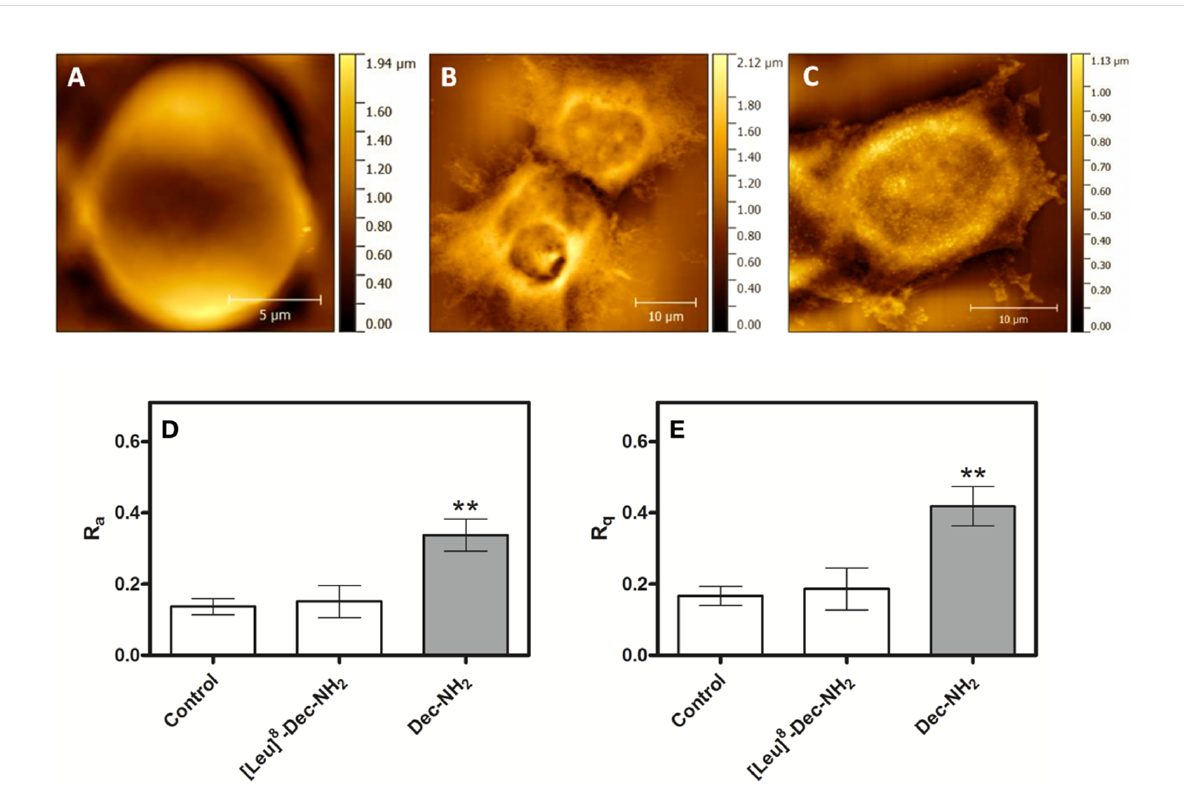
Figure 5: Topological images of untreated MCF-7 cells (A) and cells treated for 24 h with 50 μ mol L − 1 of Dec-NH 2 (B) or 50 μ mol L − 1 of [Leu] 8 -Dec- NH 2 (C). Roughness values of membranes of untreated MCF-7 cells and of those cells treated with peptides. (D) Data represent the mean values of the surface relative to the center plane of measurements ± standard deviations ( n = 5). (E) The root mean square of the values and the standard devi- ation of the area were analyzed. More than 5 points were measured per sample. Significant differences between peptide-treated and untreated cells are given by p > 0.05